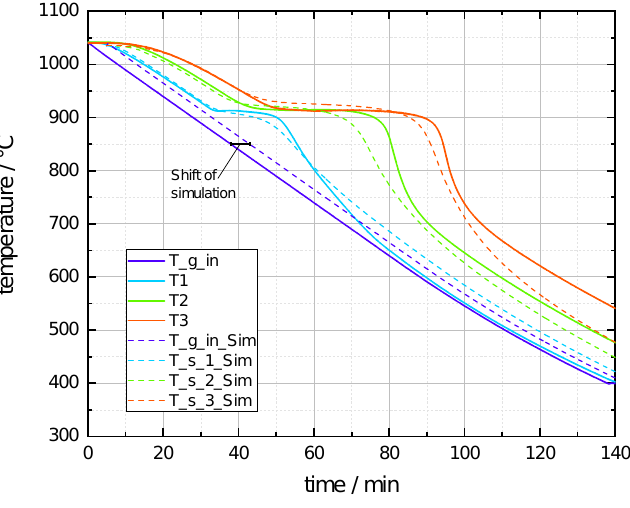
Figure 3. Simulation of dynamic cooling with oxidation of (Mn 0.75 Fe 0.25 ) 3 O 4 in a lab-scale fixed bed reactor. Solid lines display temperatures measured in the experiment, whereas dashed lines present the simulated temperatures. The simulation was shifted by 5min to allow for a better